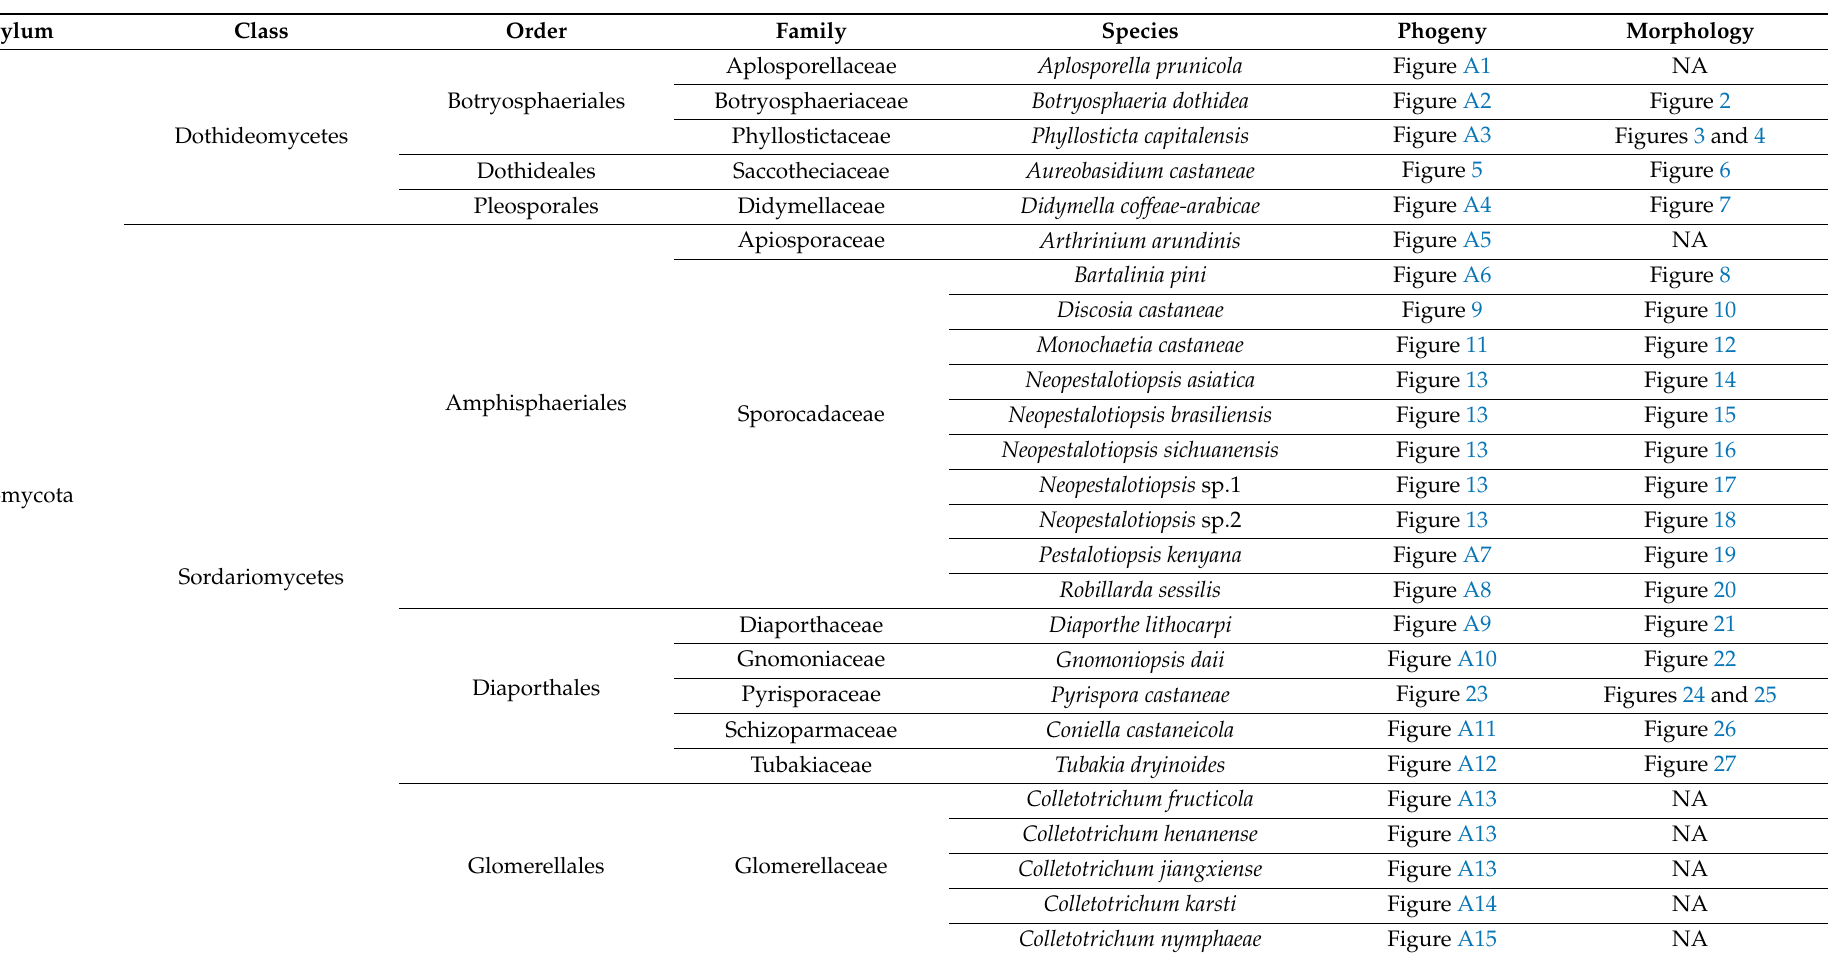
Table 3. Fungal species from Castanea